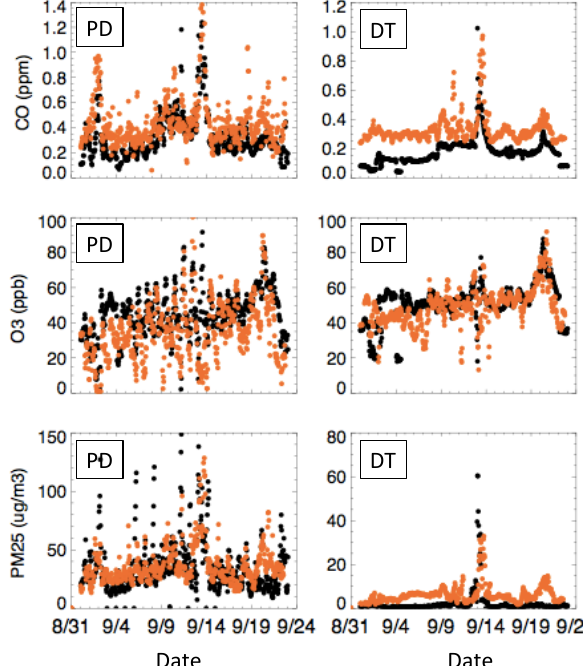
Fig. 3. The measured and calculated CO and O 3 variability at PD (left panels) and DT sites (right panels). The measured results are represented by the orange dots and calculated results by the black dots,